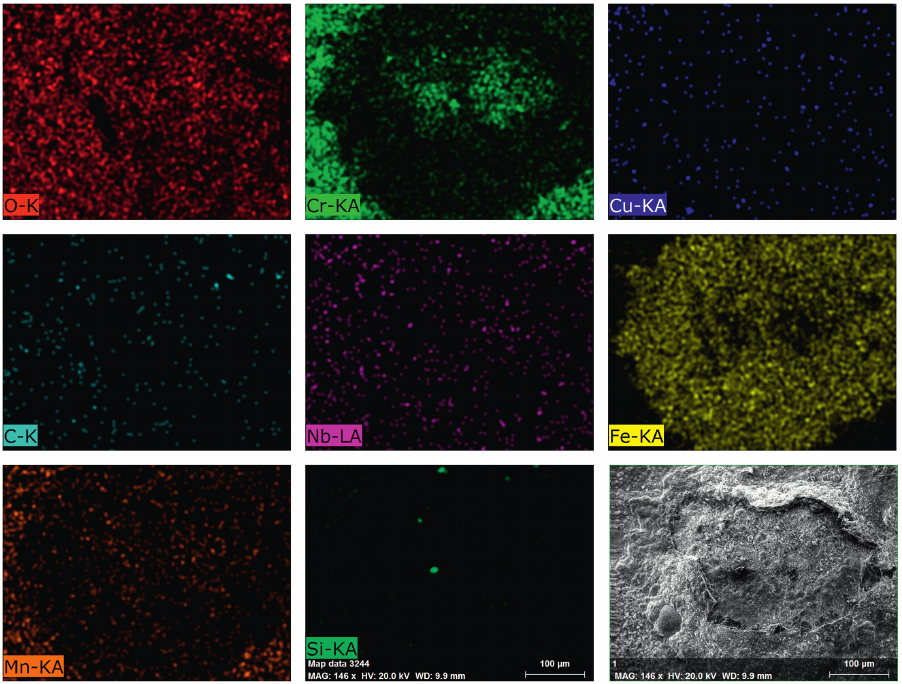
Figure 5: EDS map of the broken oxide scale and the internal oxides which developed at 1,000°C in air with 11.5 vol.% H 2